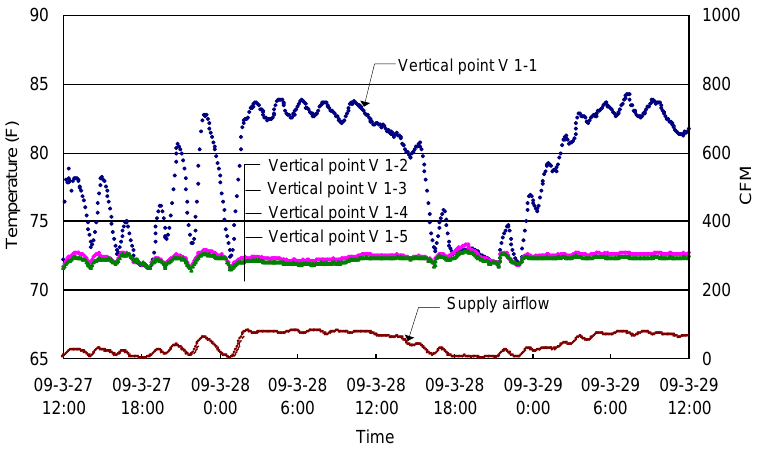
Figure 11. Trending data of vertical room air temperature at different